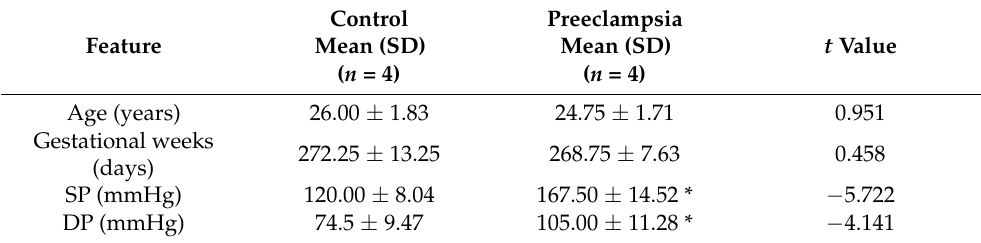
Figure 1. Changes in serum PSG9 levels in patients with preeclampsia. ( A , B ) Cluster thermographic analysis ( A ) and summary data ( B ) showing serum relative PSG9 expression levels identified by isobaric tags for relative and absolute quantitation combined with LC-MS/MS technology in healthy control (Ctrl) pregnant women and patients with preeclampsia (PE). Red indicates an increase in expression level, whereas blue indicates a decrease. The darker the color, the greater the change. ( C , D ) Representative Western blot image ( C ) and summary data ( D ) showing serum PSG9 expression levels in healthy control pregnant women and patients with preeclampsia. In ( B ) and ( D ), the mean PSG9 level for healthy control pregnant women served as the denominator, and all data were divided by this mean. Values are shown as the mean ± SEM ( n = 4 per group). * p < 0.05 for PE vs. Ctrl. Table 1. Clinical data for patients with preeclampsia and healthy control